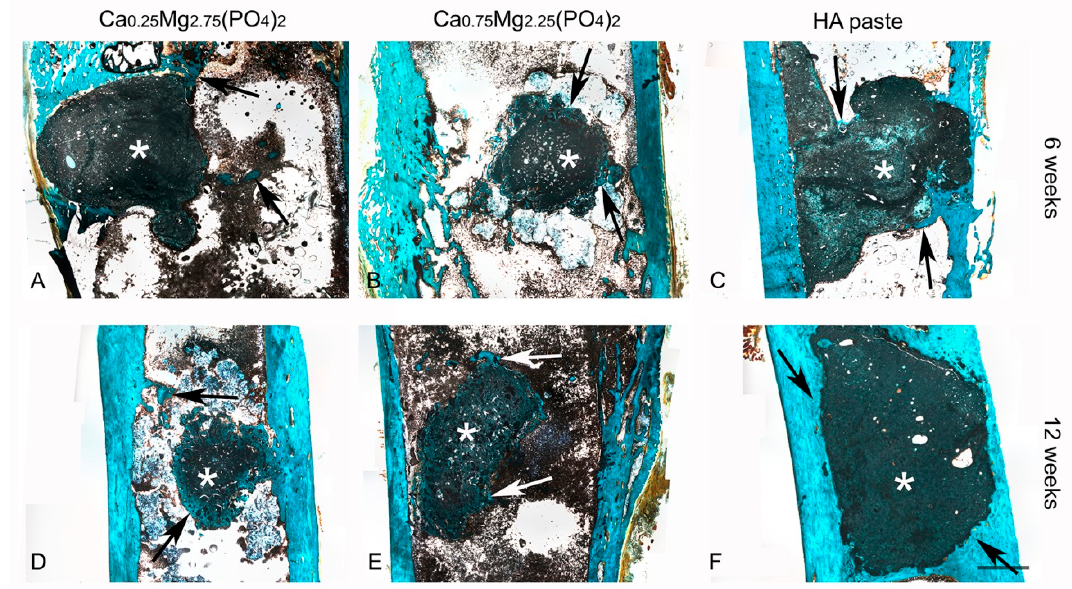
Figure 4. Histological slices of the Ca 0,25 Mg 2,75 (PO 4 ) 2 paste ( A , D ), the Ca 0,75 Mg 2,25 (PO 4 ) 2 paste ( B , E ) and HA paste ( C , F ), 6 and 12 weeks after implantation into drill hole defects at the distal lateral epicondyle of New Zealand white rabbits. The remaining cement pastes appear in dark green and black color (asterisk). Staining colors: keratin, muscle fiber: red; mineralized bone: blue / turquoise; non-mineralized bone: orange / brownish. Arrows indicate areas of newly formed bone. Scale bar = 2 mm.